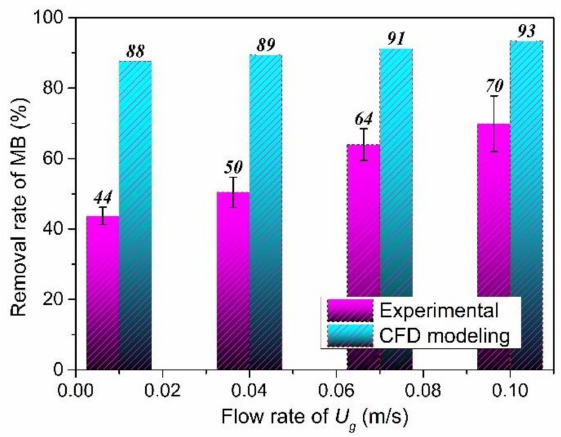
Figure 9. Comparison of experimental data and CFD